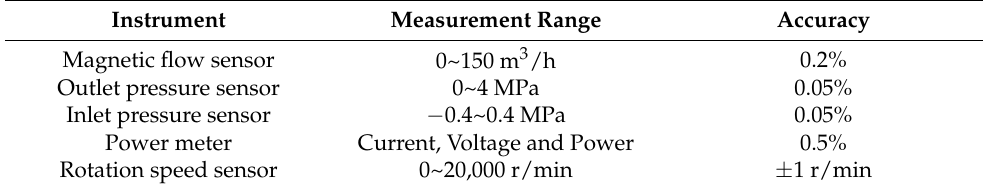
Figure 3. The centrifugal pump efficiency changes with the flow rate at different speeds. 2.2. Process Mechanism Analysis The efficiency curves at different speeds have a common feature. As flow increases, the efficiency first increases rapidly and then decreases gradually, as shown in Figure 3. The main reason is that when the outlet valve opening is small, flow into the system is small, and the system loss is large. Deviating from the design flow of centrifugal pump results in a large impact loss inside the centrifugal pump. When the valve opening grad- ually increases, the efficiency of centrifugal pump will also increase. When the best effi- ciency point of centrifugal pump is reached, the efficiency of centrifugal pump gradually decreases as the flow rate increases. This is because the excessive flow also causes the